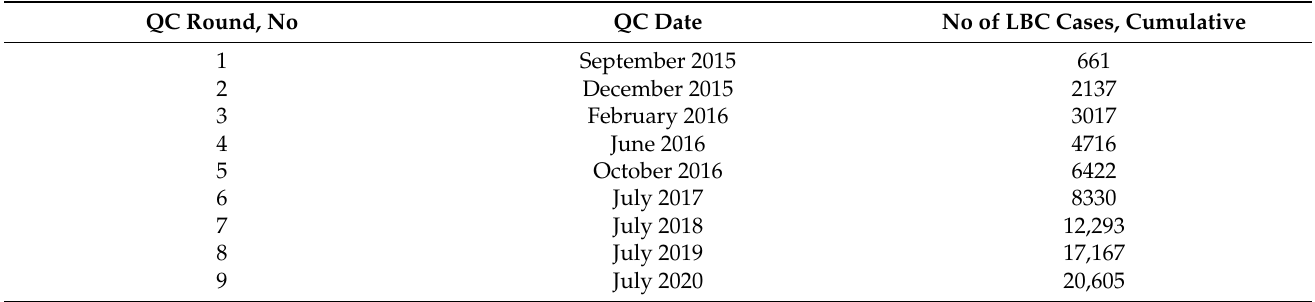
Table 10. Following QC rounds with cumulative number of LBC cases.